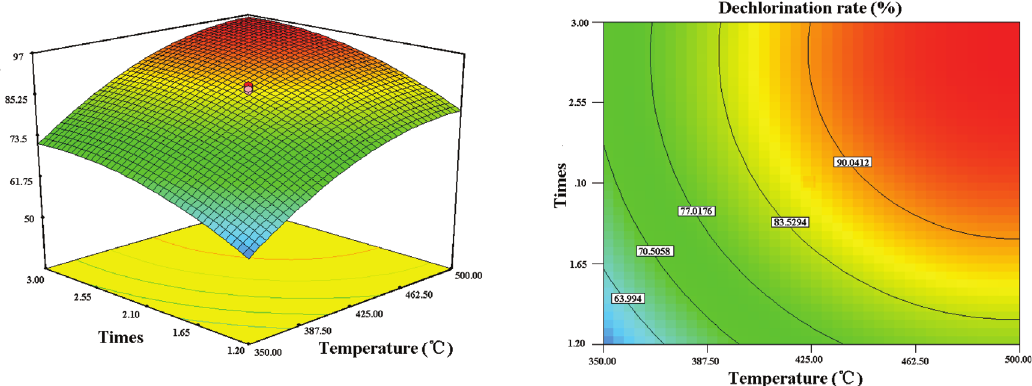
Figure 5: The interactive effects of the temperature and oxygen consumption on the dechlorination rate by microwave roasting under oxygen-enriched condition.